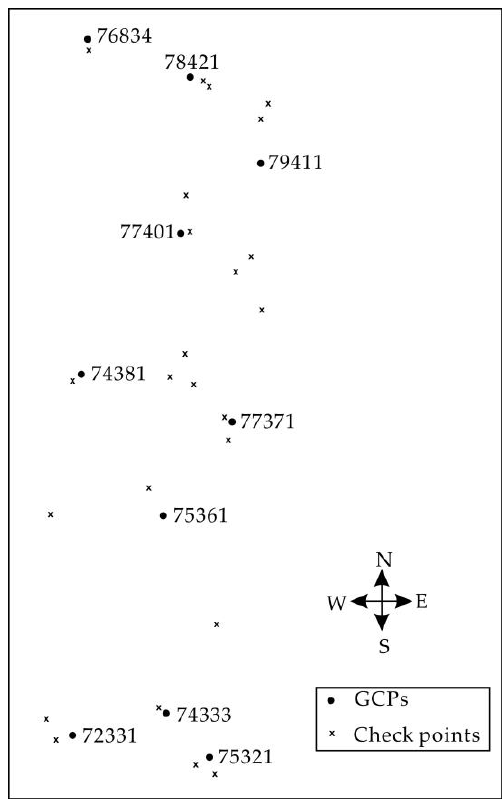
Figure 11. Distribution of 10 GCPs and check points in the test field.